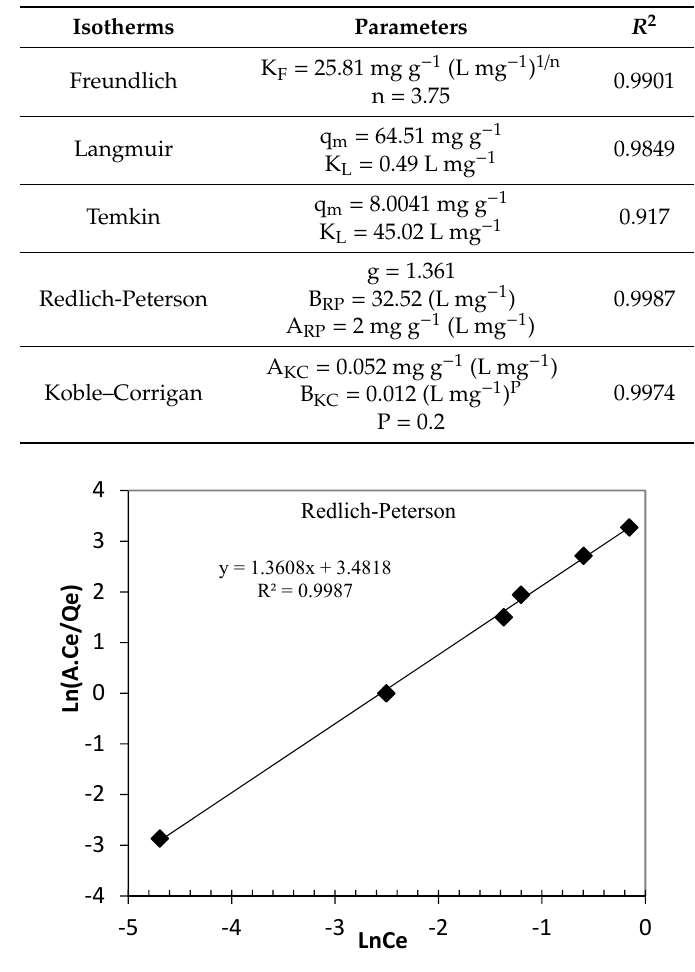
Figure 10. The linearized Redlich–Peterson isotherm model for arsenic sorption onto iron nanoparticles.